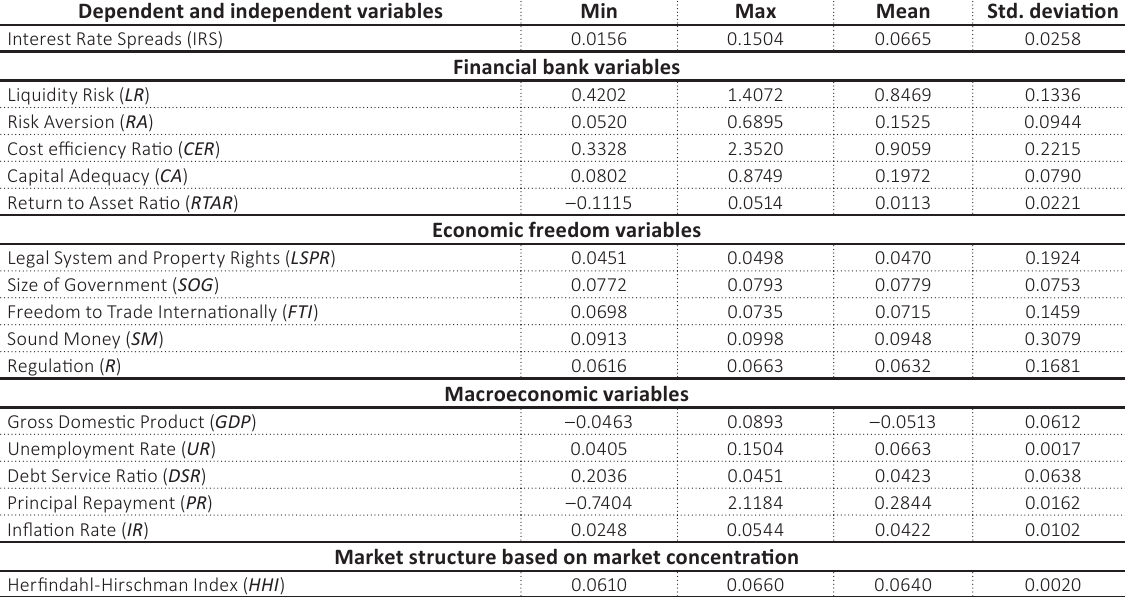
Source: Eviews 9 data processing